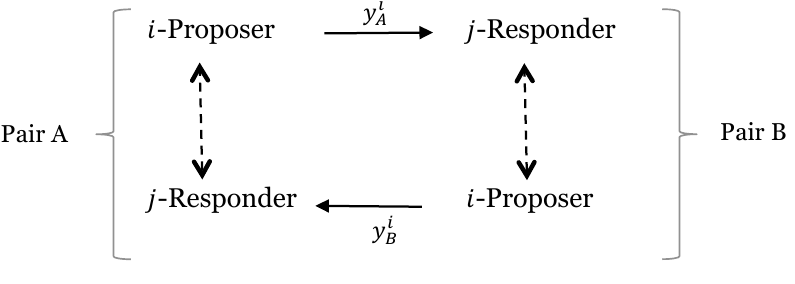
Figure 1. The matching within and between pairs. Notes: Solid arrows represent the factual offers by the proposers, while bi-directed arrows represent the conditioning on offers within pair A and pair Figure 1 : Random selection whether i or j is endowed and offering in both pairs; i,j=e,o with ! ≠ ! . Dash-arrows refer to conditioning while actual offers are represented by arrows.